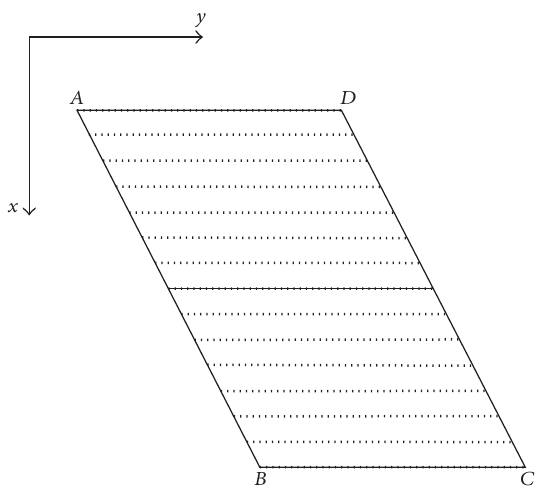
Figure 1: Transformed numerical